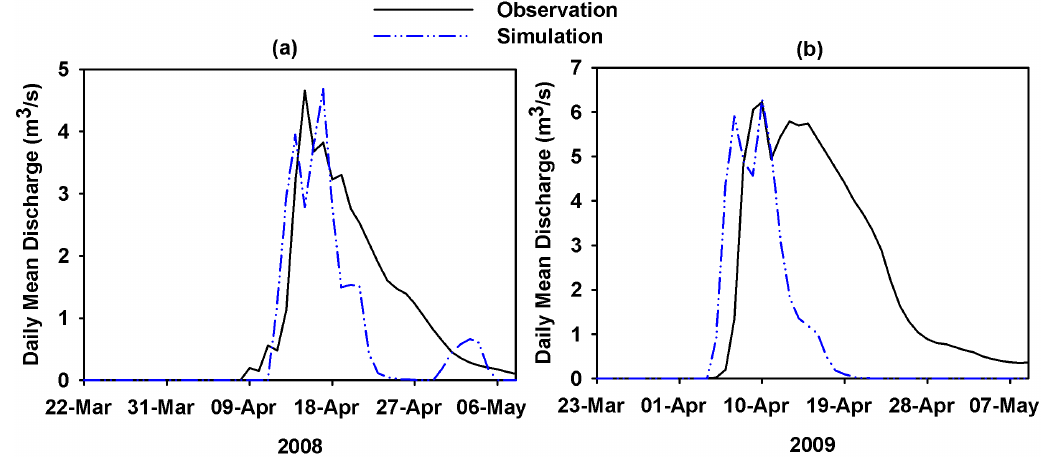
Fig. 10. Comparisons of the observed and simulated spring daily mean discharge in the Smith Creek Research Basin. (a) 2008 simulation period and (b) 2009 simulation period.